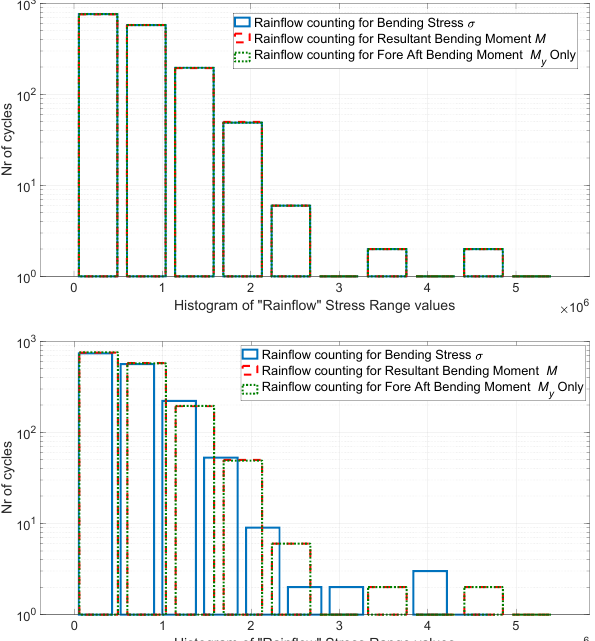
Figure 15. Histograms of 10 min bending stress σ , resultant bending moment M , and fore-aft bending moment M y time series for below-rated mean wind speed (6 m/s), set θ = 0 ◦ , τ = 0 ◦ ( above ), set θ = 60 ◦ τ = 30 ◦ ( below ).